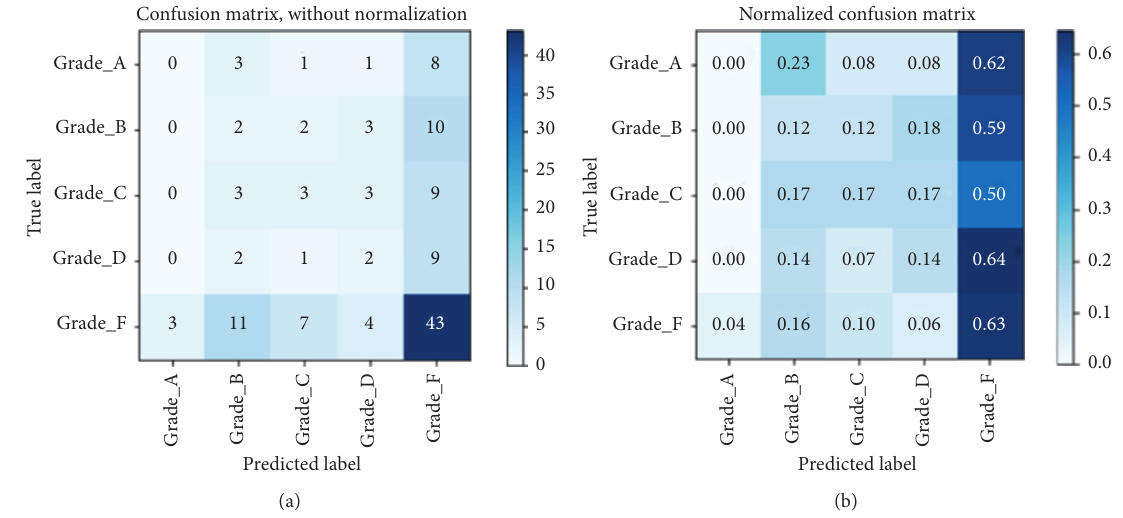
Figure 11: Confusion matrices of M-learning model 4, without normalization and normalized confusion matrix. (a) Without normal- ization. (b) With normalization.